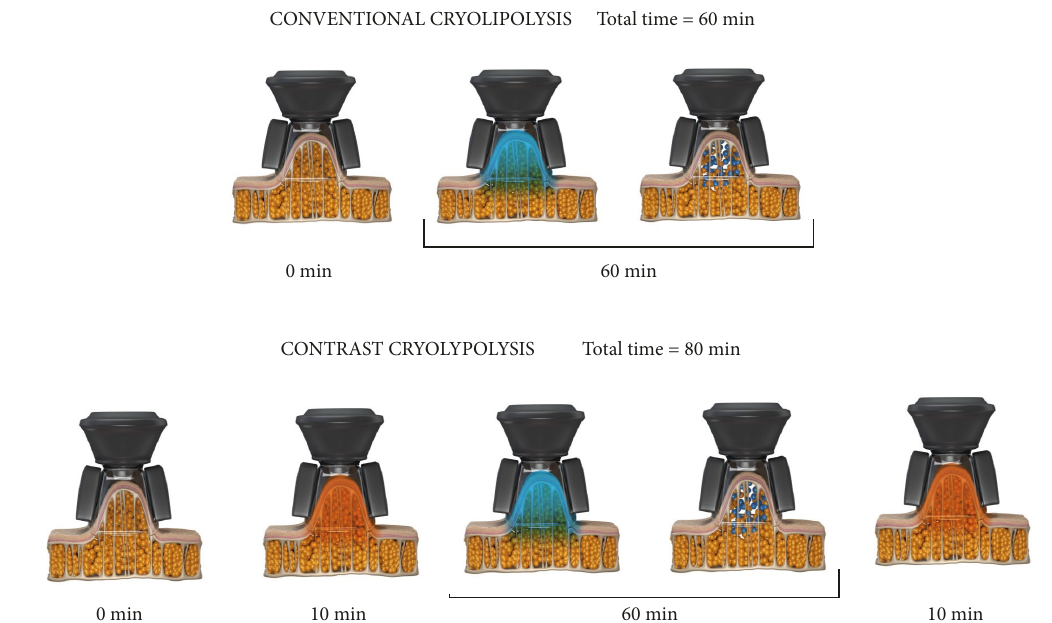
Figure 1: A comparison between conventional cryolipolysis and contrast cryolipolysis.